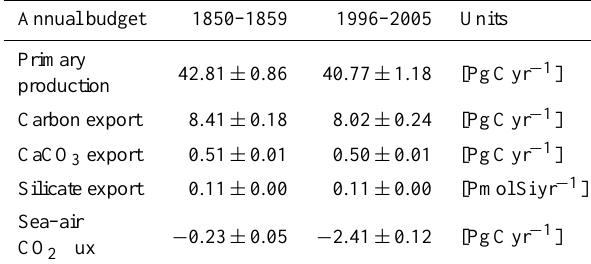
Table 2. Globally integrated annual net primary production, carbon export production, calcium carbonate export, silicate export produc- tion, and sea–air CO 2 flux (negative represents ocean uptake), com- puted for preindustrial and contemporary (centered at year 2000) periods.